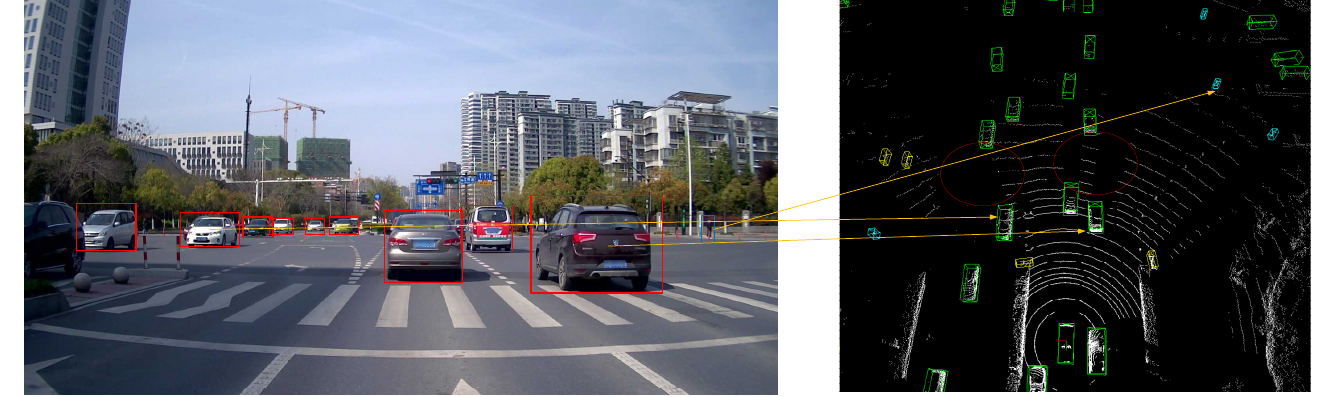
Figure 1. Comparison between 2D object detection and 3D object detection.